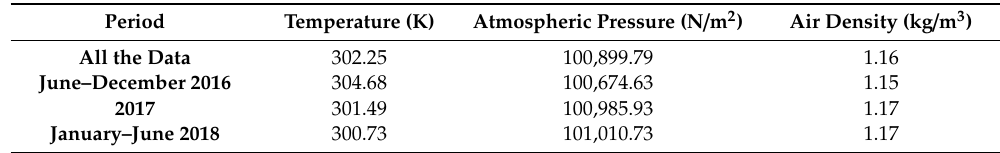
Table 5. Environmental parameters.